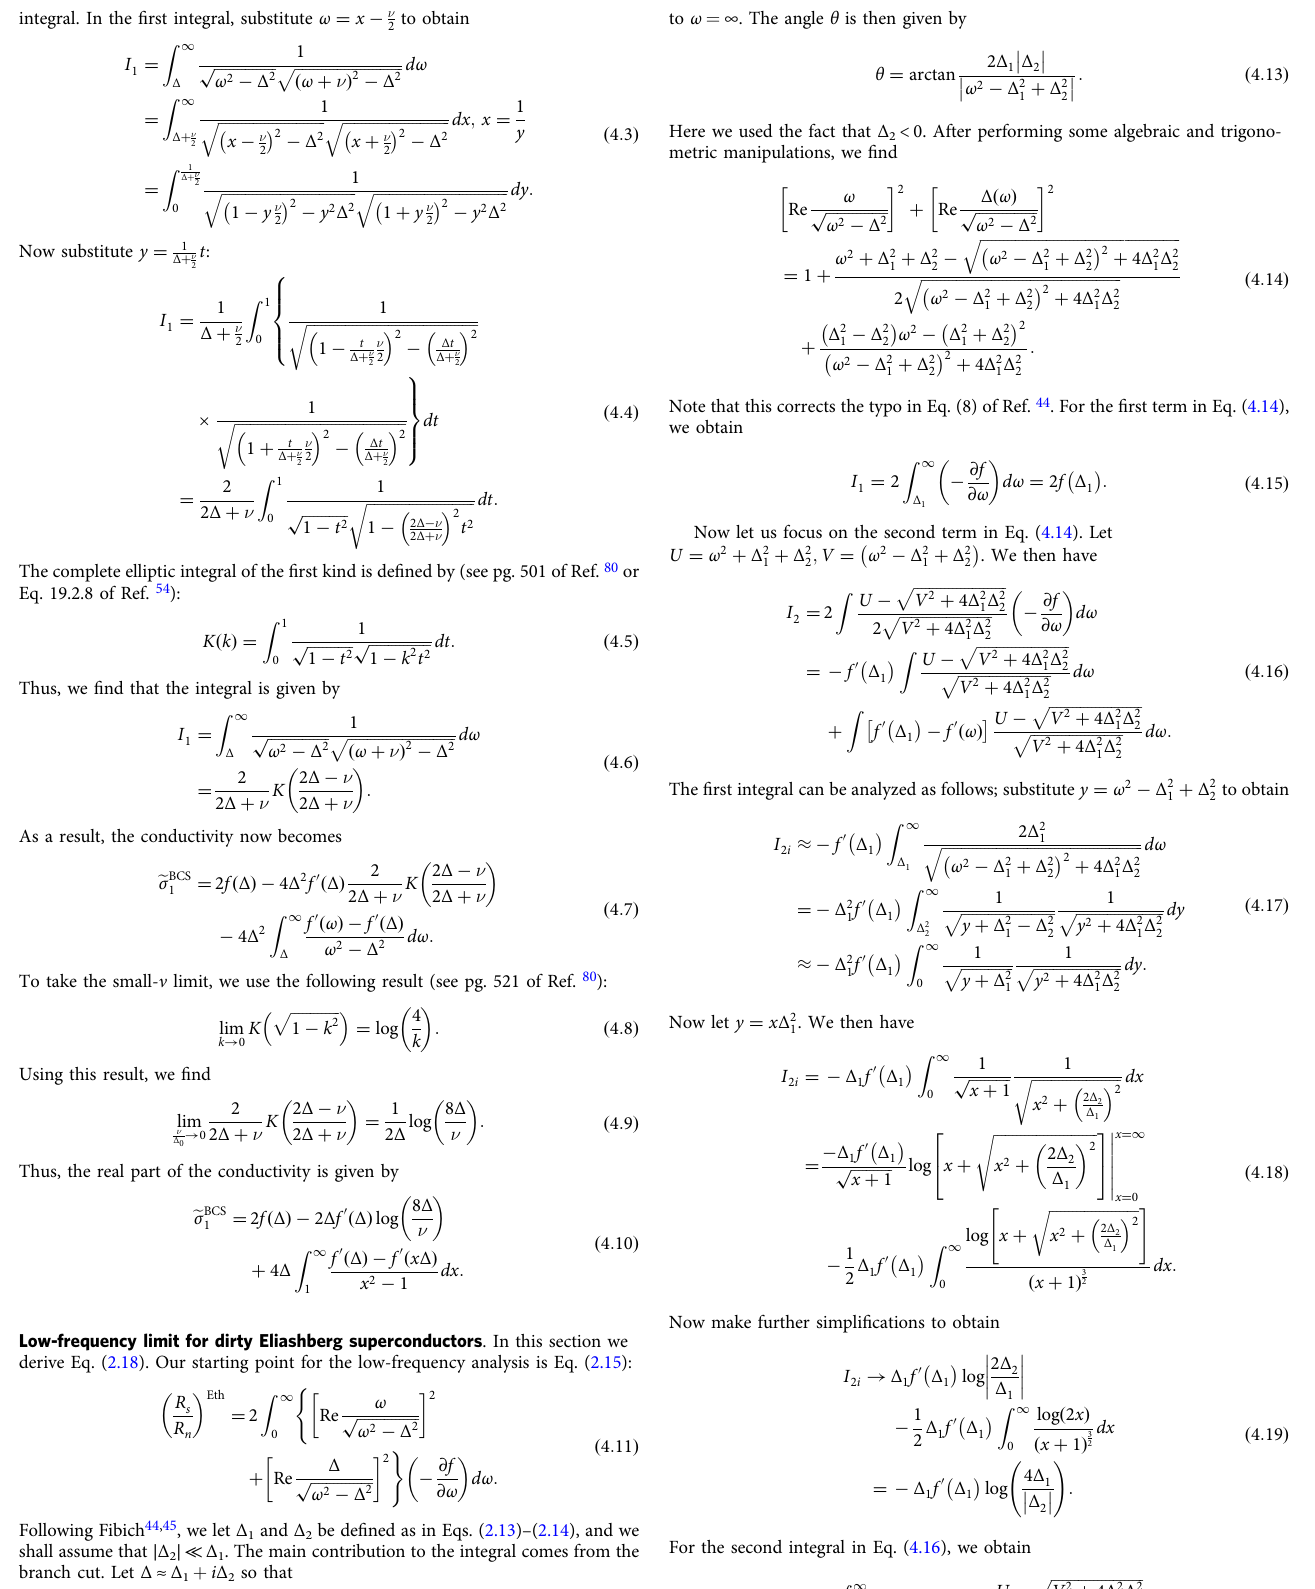
p ffiffiffiffiffiffiffiffiffiffiffiffiffiffiffiffiffiffiffiffiffiffiffiffiffiffiffiffi ω 2 (cid:1) Δ 2